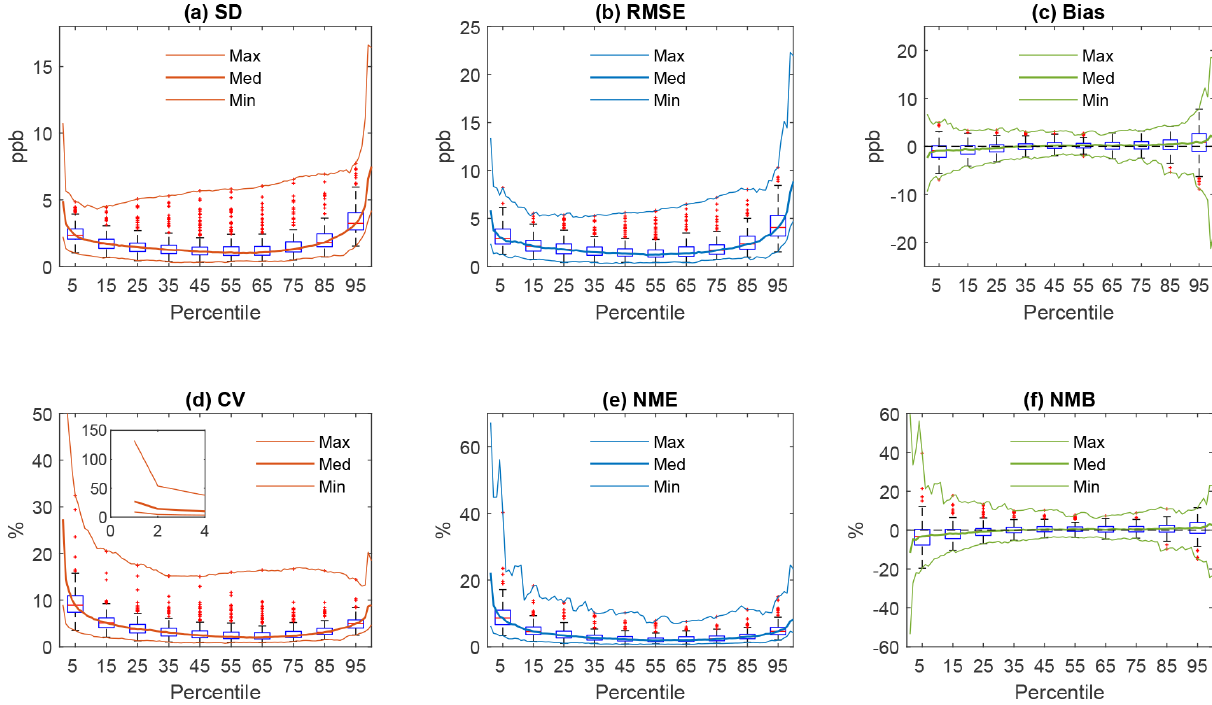
Figure 4. Box plots of statistical metrics based on the results from the analysis of DM8HR data at 185 monitoring sites: (a) standard deviation, (b) root mean square error, (c) mean bias, (d) coefficient of variation, (e) normalized mean error, and (f) normalized mean bias. The lower and upper edges of the boxes represent the 25th and 75th percentile values, while the whiskers represent the 5th and 95th percentiles. See data analysis procedures using the ozone baseline observed in the year 2010 as the target baseline in Eqs. (7) and (8) of Luo et al.